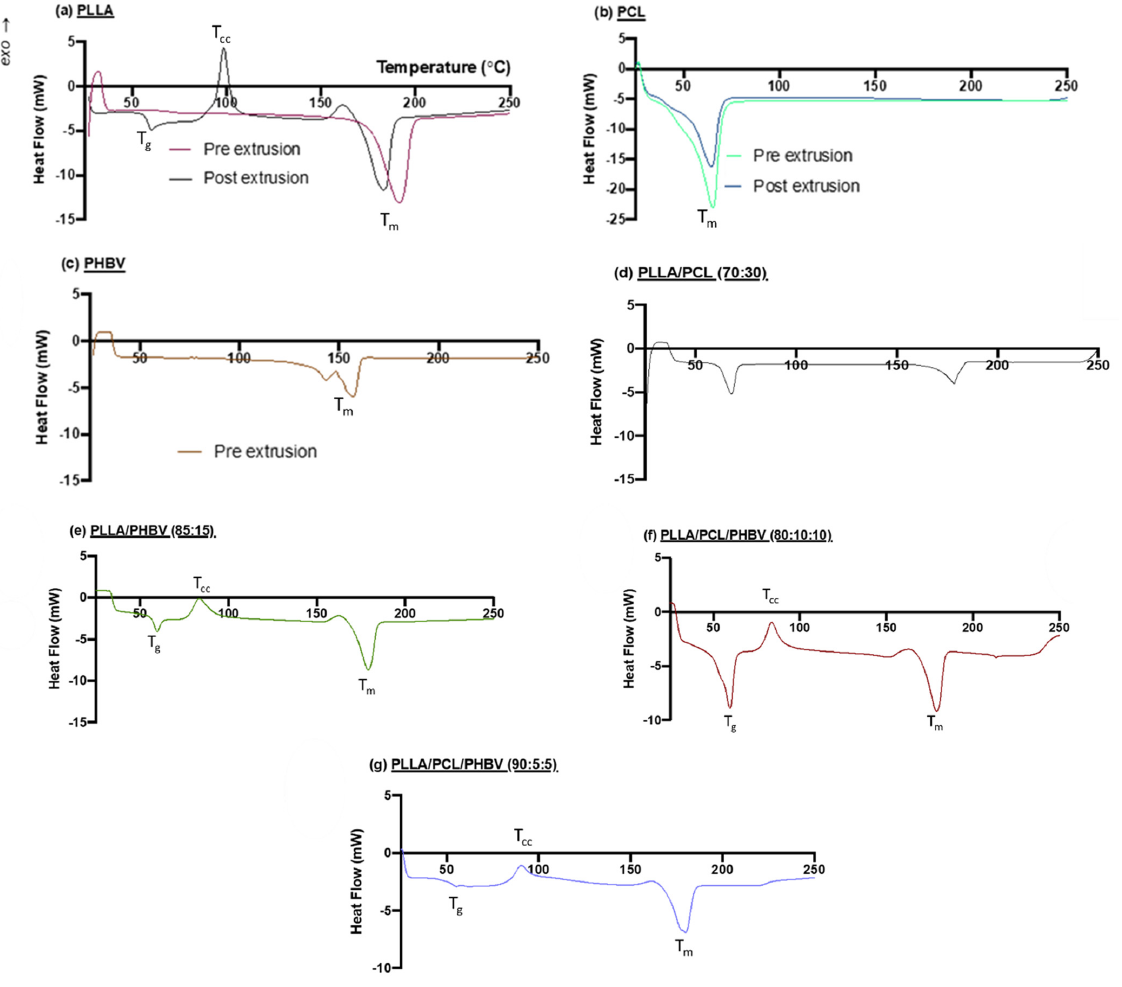
Figure 2. DSC curves ( a ) PLLA, ( b ) PCL, ( c ) PHBV, ( d ) PLLA/PCL (70:30), ( e ) PLLA/PHBV (85:15), ( f ) PLLA/PCL/PHBV (80:10:10) and ( g ) PLLA/PCL/PHBV (90:5:5). Table 2. Thermal characteristics and crystallinity. omr indicates effect outside the measurement range; nm indicates effect not measurable. Results for blended materials are all post-extrusion. Δ H cc for samples which did not show a cold crystallinity peak assumed to be 0. PLLA and PHBV cold crystallisation peaks or melt peaks closely align, so a single value is reported. PCL melting peaks were distinct, and so the blends containing PCL values are reported separately for PCL and the other components of the blend.